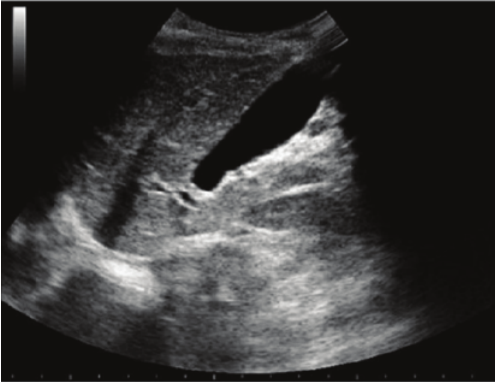
F 1: Hepatic ultrasound showing a distended gallbladder.